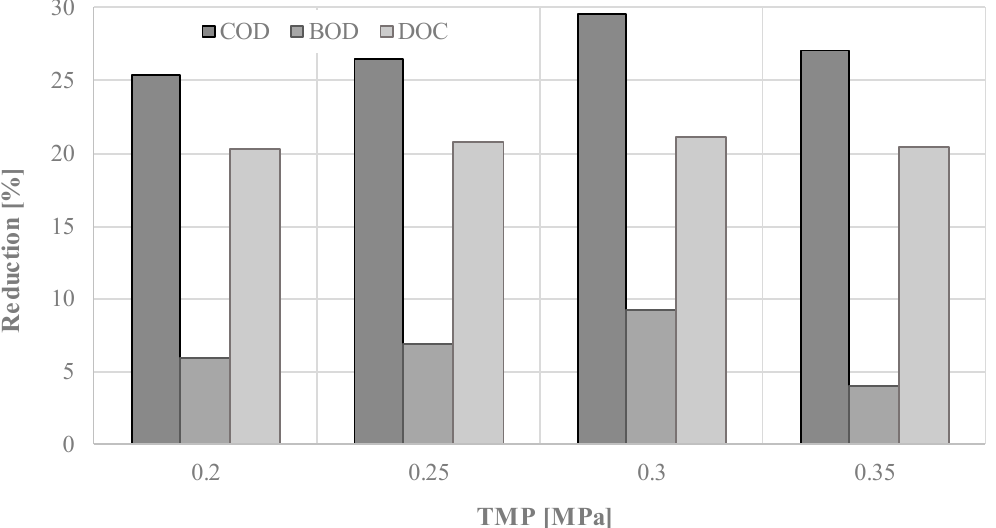
Figure 6. Reduction of the organic substances in the liquid fraction of digestate, for di ff erent TMP, using 10 kDa ultrafiltration membrane.